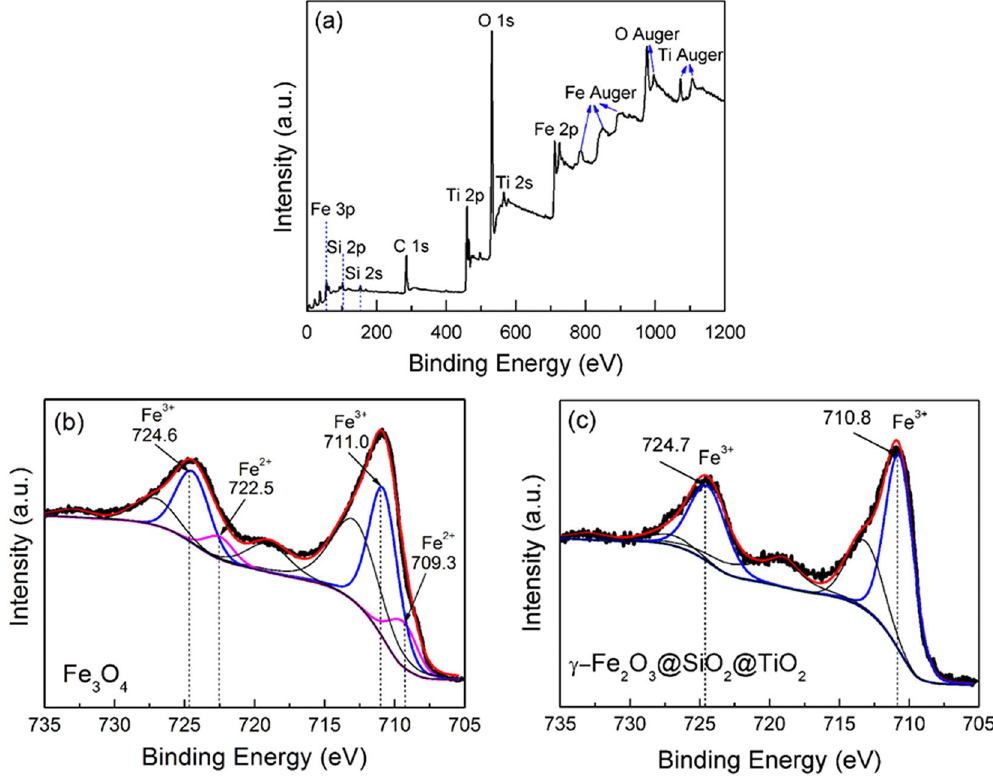
Figure 2. ( a ) A full-scan XPS spectra of γ -Fe 2 O 3 @SiO 2 @TiO 2 heterostructure, ( b , c ) The Fe 2 p core-level XPS spectra for